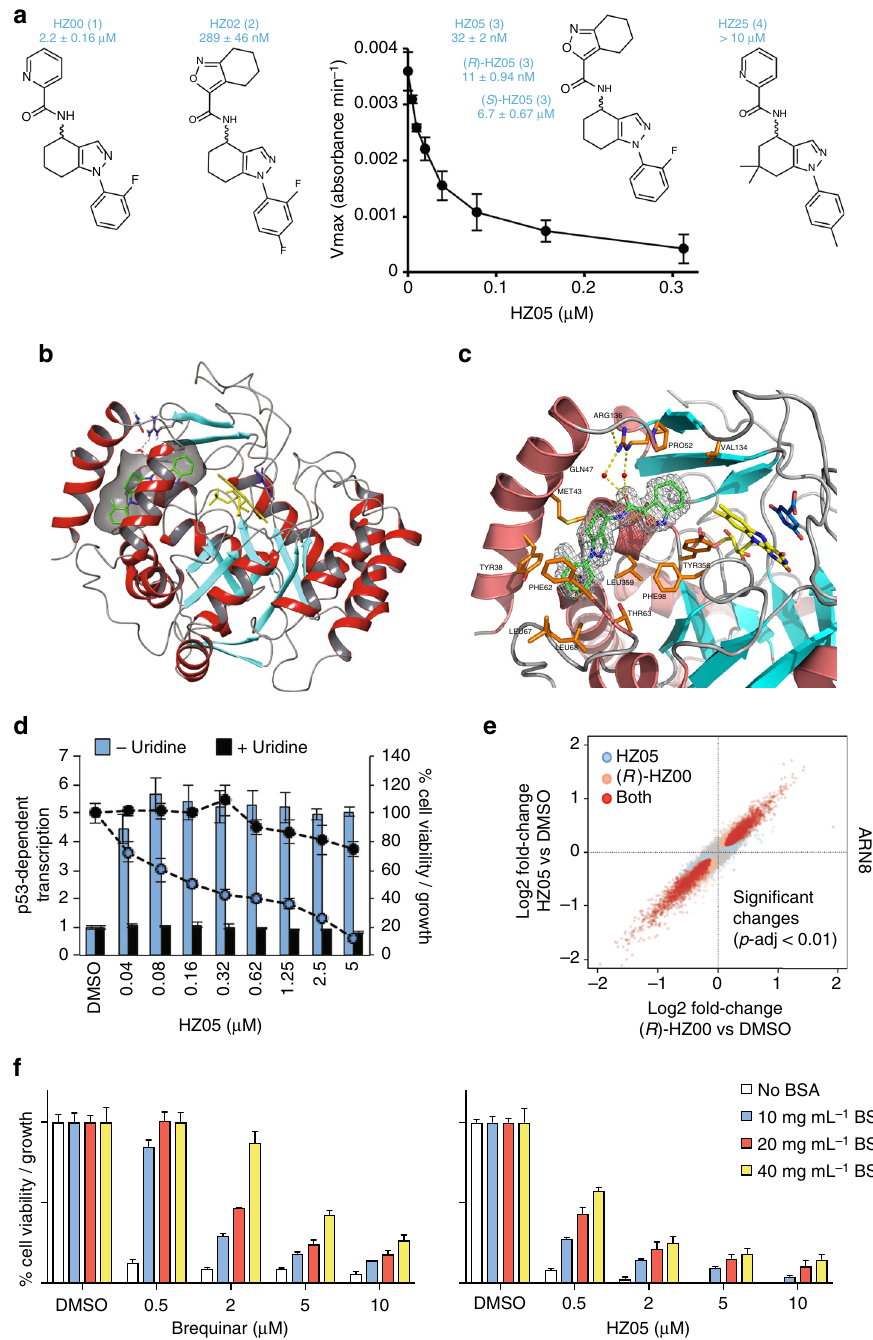
Fig. 5 Characterization of the more potent analog HZ05. a Compound structures and IC 50 values obtained using a kinetic DHODH enzyme assay. Values correspond to the average of three independent repeats ± SD with three technical repeats each. b X-ray co-crystal structure of ( R )-HZ05 (green carbons) with DHODH (6ET4). Protein helices are colored light red and the sheets in cyan. The carbons of the co-factor FMN are shown in yellow and the carbons of the reaction product orotate in blue. c ( R )-HZ05, shown with green carbons, binds in the same pocket as other inhibitors such as brequinar. In this structure, the pocket is opened up as Gln47 (purple) is moved out, allowing ( R )-HZ05 to make interactions with the Arg136 (orange) through two water molecules. Other amino acid residues within 4 Å from ( R )-HZ05 are shown in orange. Ala55, His56, and Ala59 are located on helix number 3; however, the entire helix number 3 has been omitted for clarity. Also for clarity, Thr360 and Pro364 located below ( R )-HZ05 are not labeled. The electron density of ( R )-HZ05 is shown in light gray. Crystallography studies were performed as described in Supplementary Information. d p53-dependent transcription (bars) and viability/growth (lines) in ARN8 cell cultures in response to HZ05 in the absence and presence of 100 μ M uridine. Values correspond to the average of three technical repeats± SD. e Comparison between the effects of 20 μ M (R)- HZ00 and 5 μ M HZ05 on RNA levels (RNASeq experiment) in ARN8 cells treated with either compound for 5 h (Supplementary Data 1). f ARN8 cells were grown in DMEM supplemented with 5% FBS and treated with the indicated compounds for 72 h in the presence of increasing levels of bovine serum albumin (BSA). Following treatment, cells were processed for an SRB assay. Values correspond to the average of three technical repeats ±